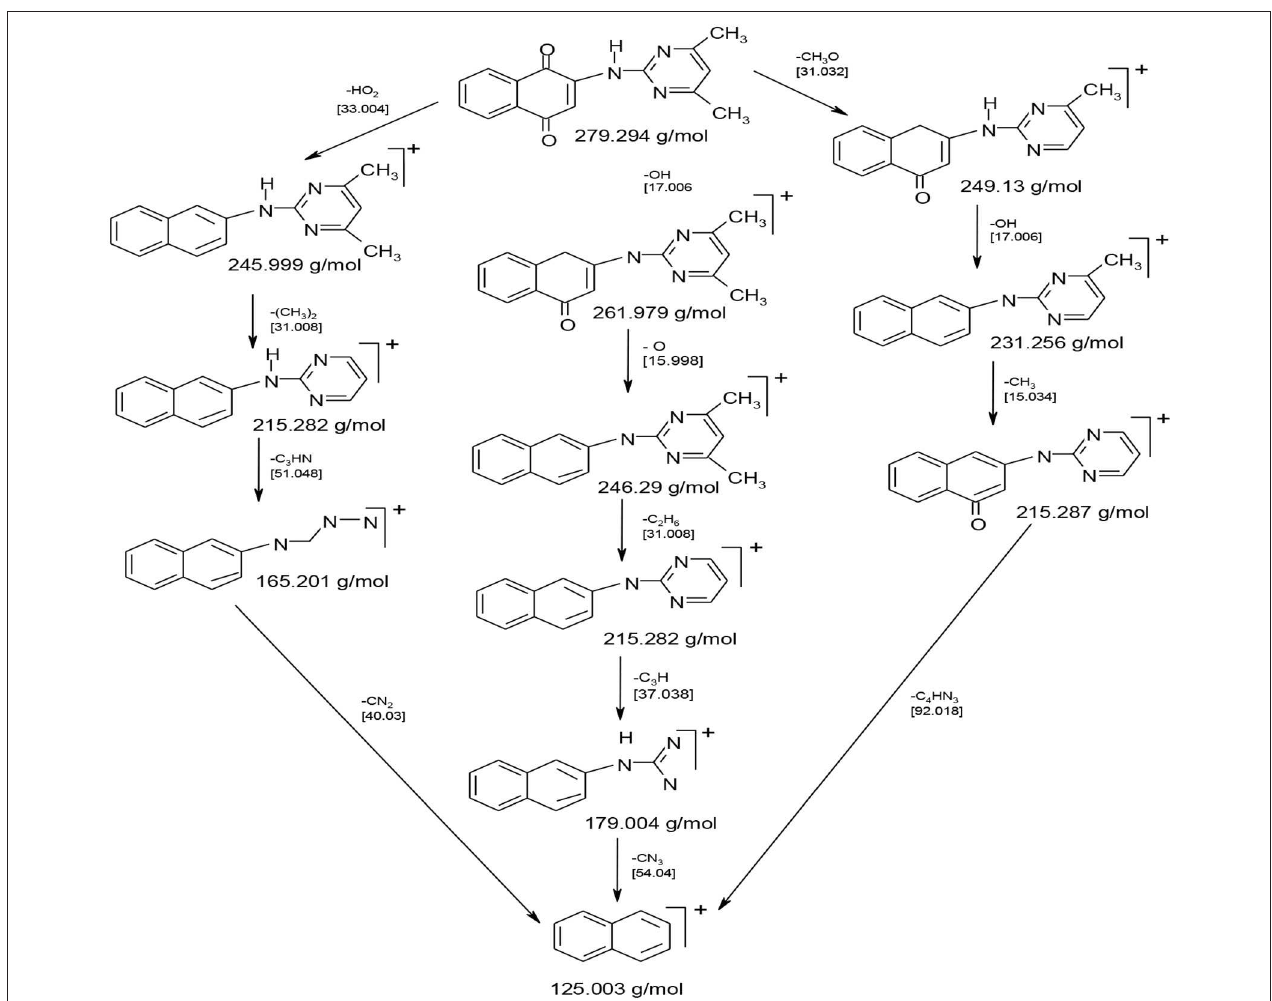
SCHEME 3 | Fragmentation pattern of HL.